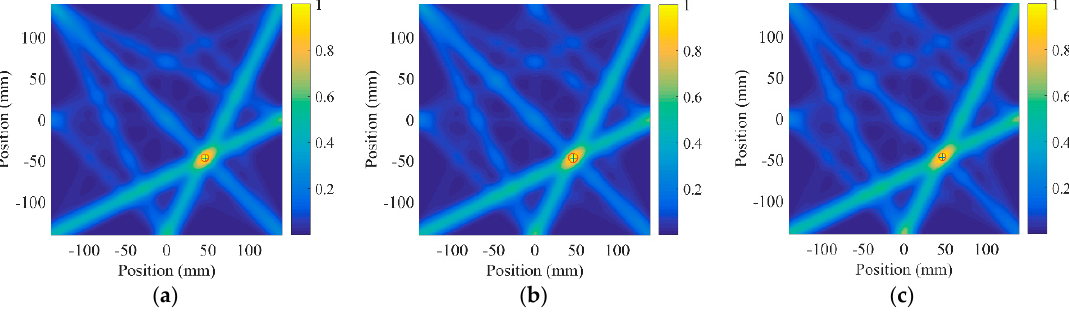
Figure 13. ETRM-based damage imaging results at different weight values ( a ) weight =0.1, ( b ) weight =0.2 and ( c ) weight =0.3.